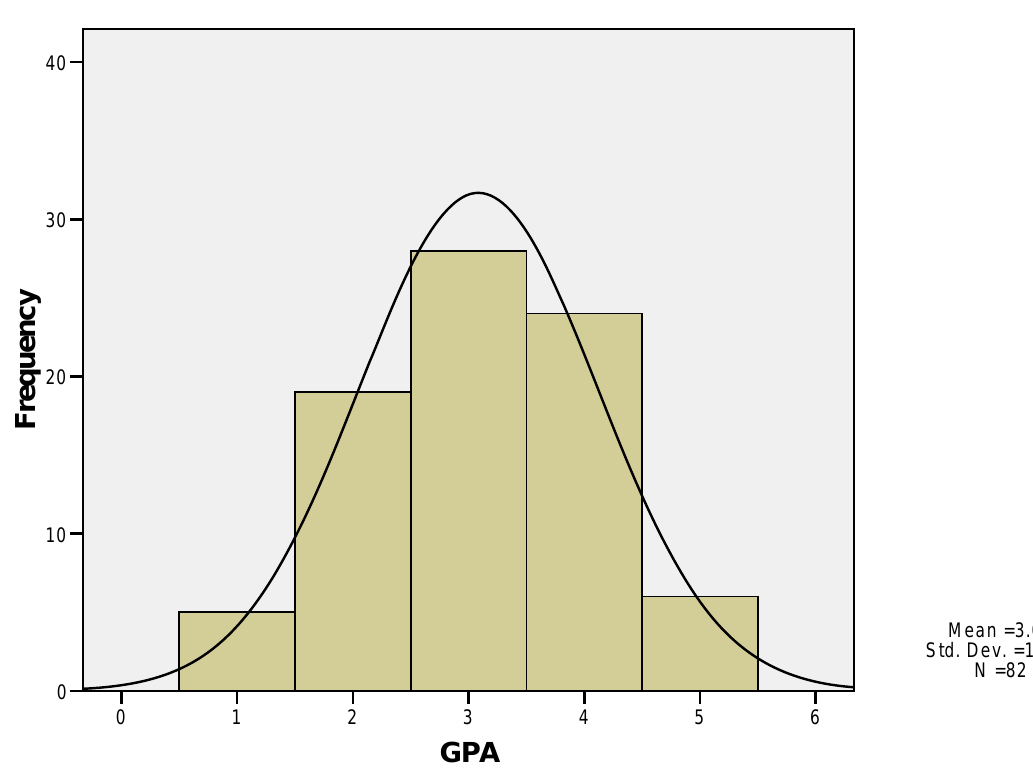
Figure 1. Distribution of Grade Point Average Overlain with the Normal